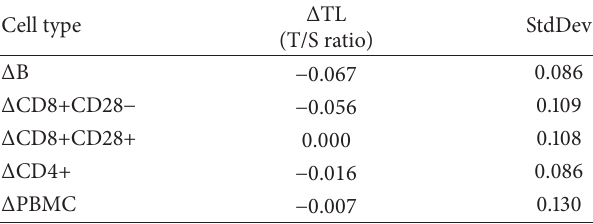
Table 5: Telomere length change in different cell types.